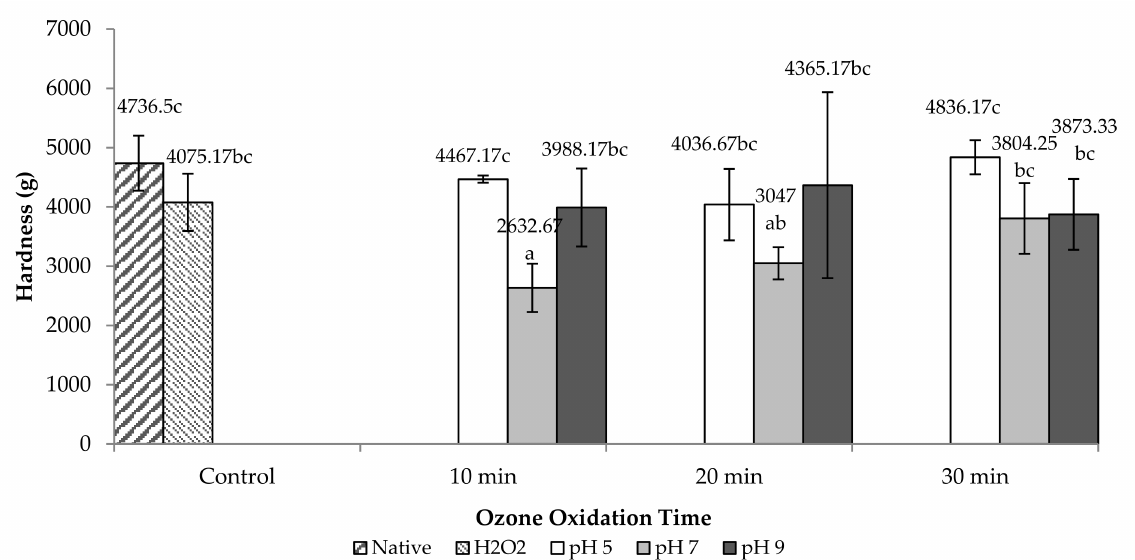
Figure 4. Hardness of ozone-oxidized tapioca-coated peanuts compared with native and H 2 O 2 -oxidized tapioca. Bars represent the standard deviation ( n = 3). Different uppercase letters on the bars indicate the significant difference ( P < 0.05).